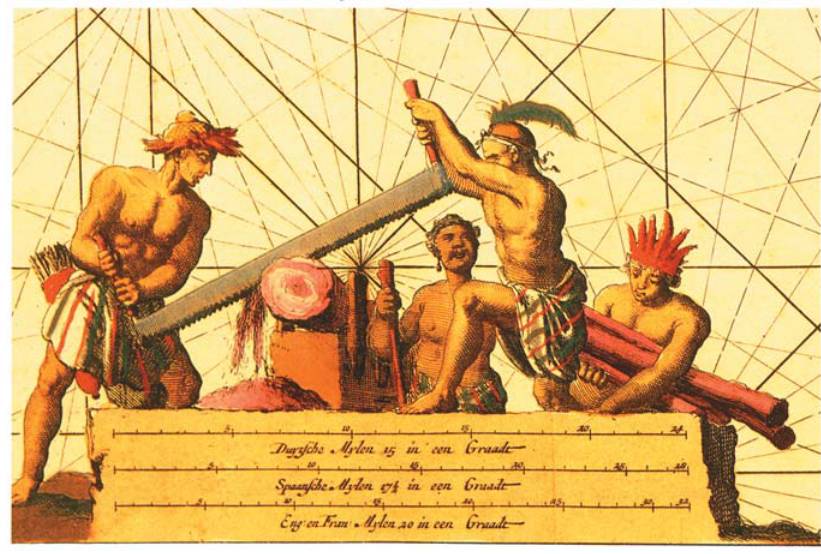
Fig. 9 – Detail of Chart of Tusschen Bahia Baxa (Punto de Lucena) made by Johannes van Keulen, 1683 (Amado and Figueiredo